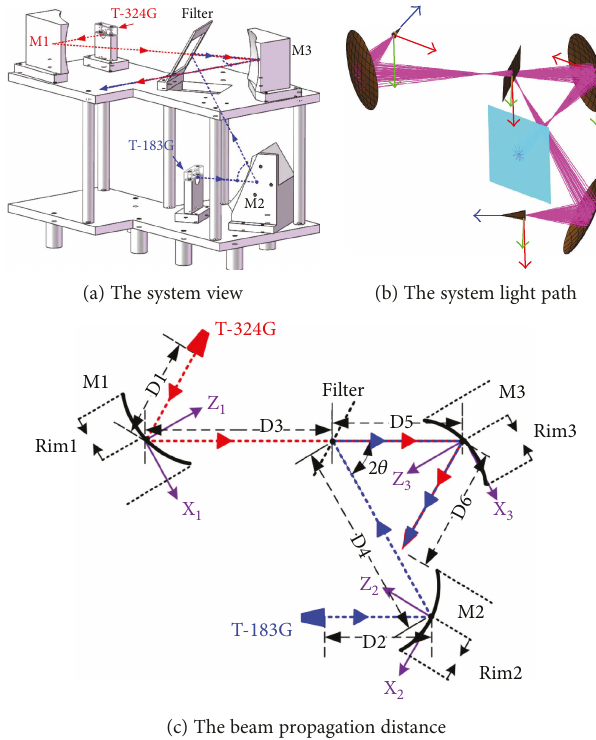
Figure 1: The dual-channel 3D QON system with 183GHz and 324GHz.